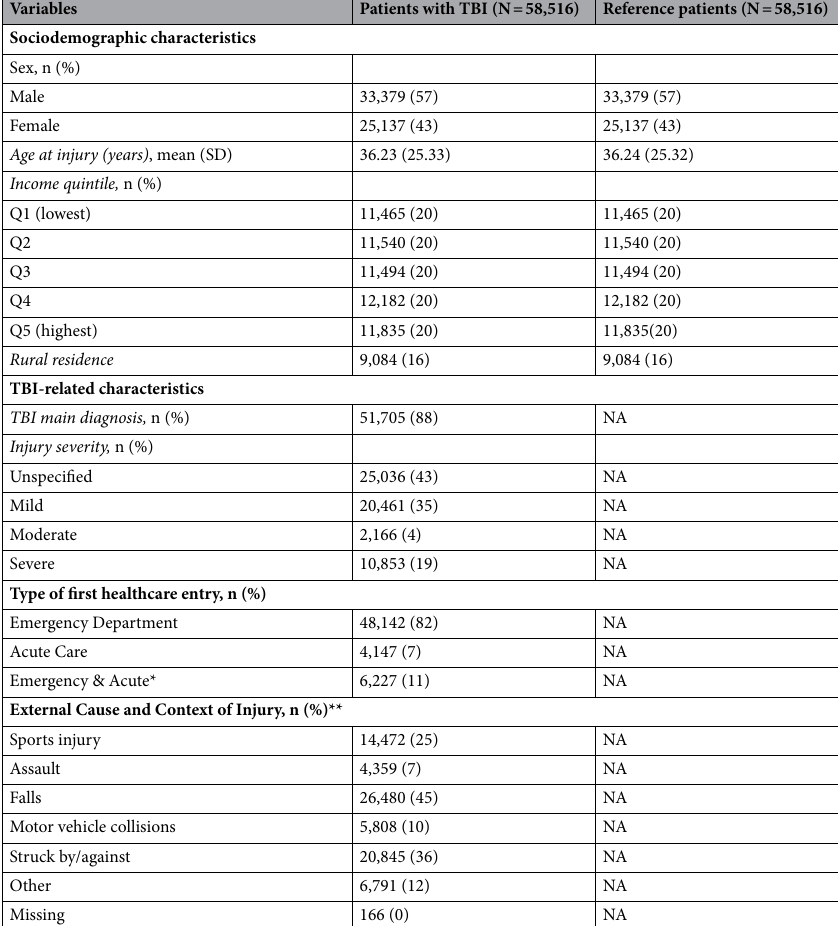
Table 1. Characteristics of patients with a first traumatic brain injury-related visit in the ED or acute care and matched reference patients. n/a = not applicable; TBI = traumatic brain injury; SD = standard deviation. Data given as mean (standard deviation) or n (%). *A patient had a transfer to either location on the same day. **A patient may have several designations (i.e., sports injury and struct by/against an